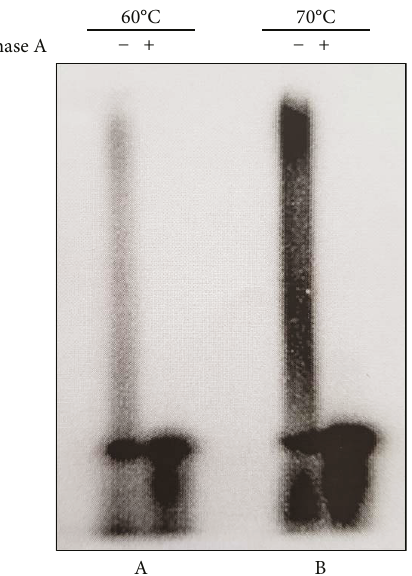
Figure 1: Transcriptional activity of S. solfataricus whole cell extracts. In vitro transcription reactions were performed using S. solfataricus S30 fractions with ( α - 32 P) UTP in di ff erent experimental conditions as described in Material and Methods and Table 1. Reaction A was incubated at 60 ° C while reaction B was incubated at 70 ° C. Total RNA was extracted from the reaction mixes, and an aliquot of the samples was treated with RNase A at 37 ° C for 30 min. The products of in vitro transcription were subjected to nondenaturing polyacrylamide gel electrophoresis, and thoseincorporating( α - 32